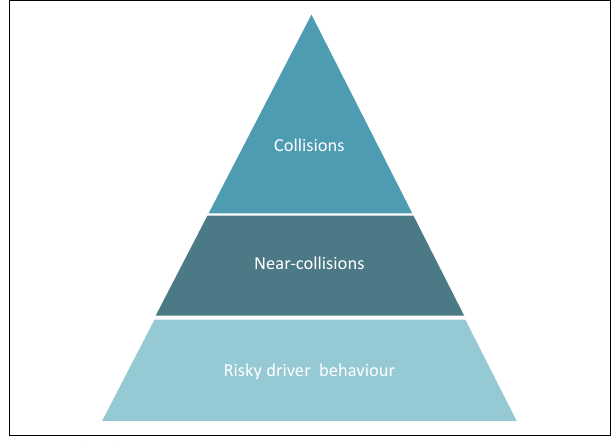
FIGURE 2: Critical incident triangle